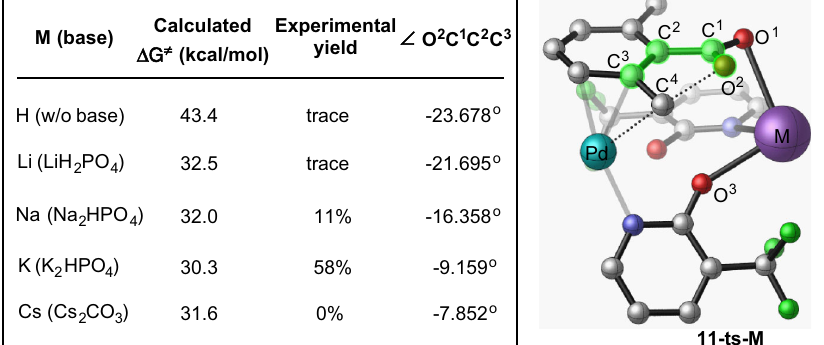
Fig. 5 Different alkali metal base effects. a Calculated activation free energy barriers, experimental yields, and dihedral angles with different bases, and b Geometry of the key transition state 11-ts-M (The hydrogen atoms are omitted for clarity).